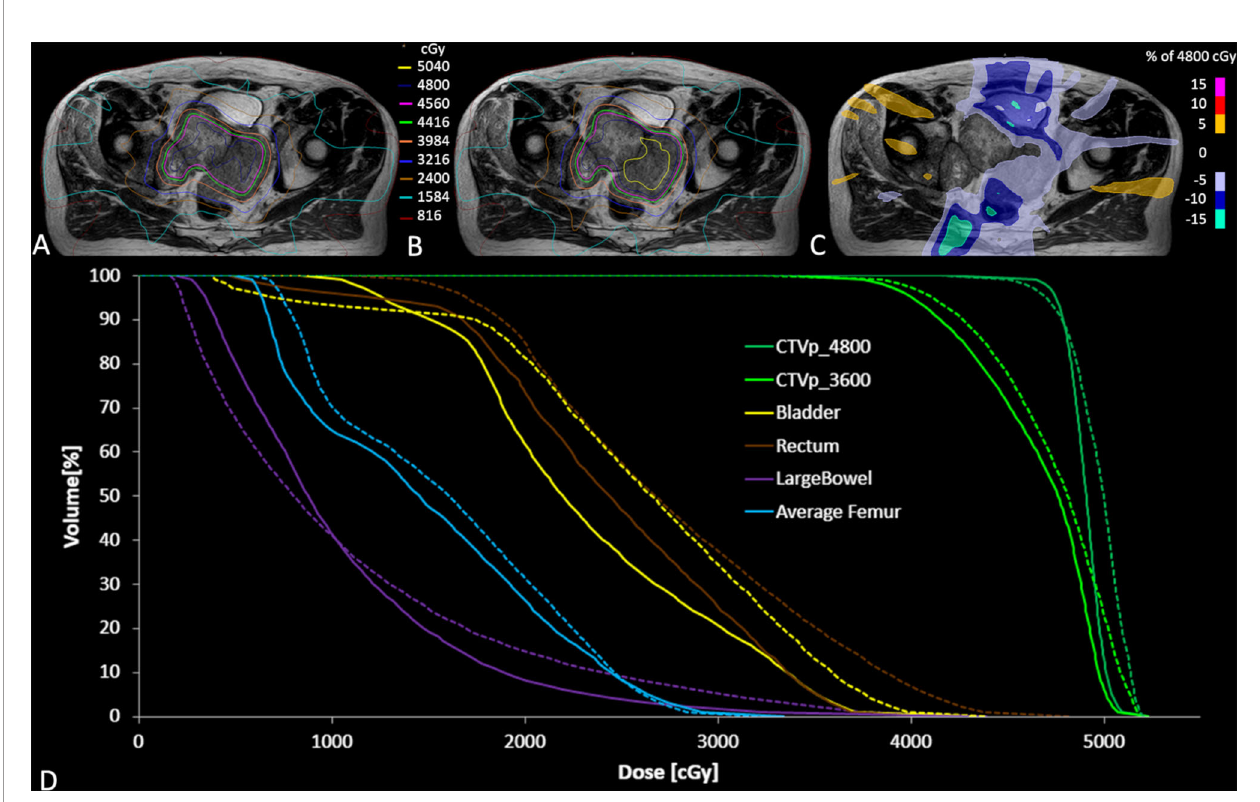
FIGURE 3 | Accumulated dose for all fractions on the reference MR scan for the clinically delivered treatment plan (A) , and simulated dose distribution without daily adaptation (B) along with the dose difference for the adapted plan minus non-adapted plan (C) . The accumulated DVH curves for both the adapted (solid lines) and non-adapted (dotted lines) are also illustrated (D) .